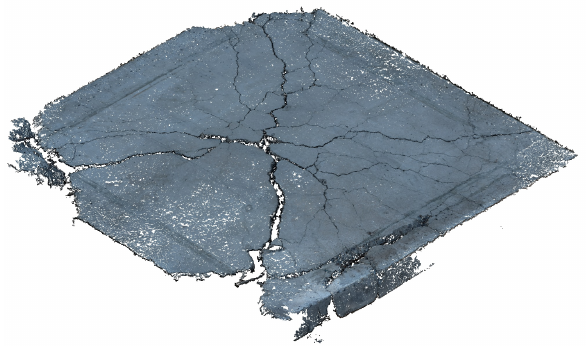
Figure 4. Point cloud of plate in shadow with Fujifilm